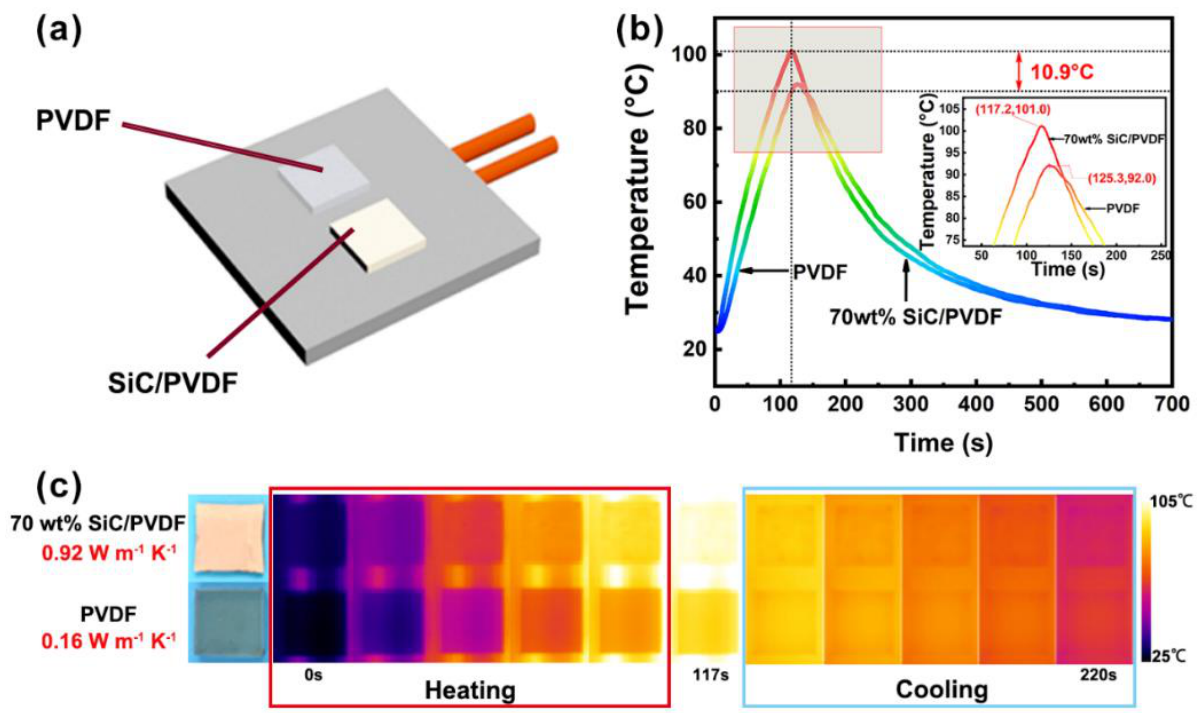
Figure 6. ( a ) Schematic diagram of heating device; ( b ) temperature – time curves, and ( c ) corresponding infrared images of 70 wt% SiC/PVDF composite and pure PVDF during and after heating. 70 wt% SiC/PVDF composite and pure PVDF during and after